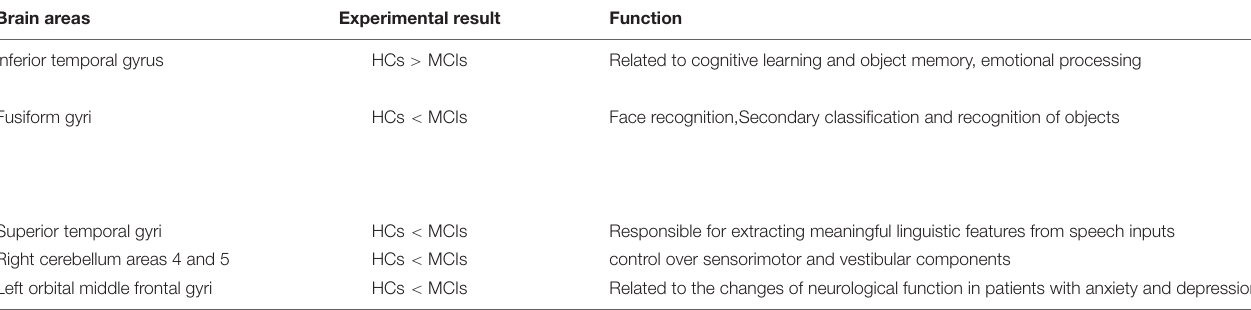
TABLE 4 | Brain areas alteration and its potential